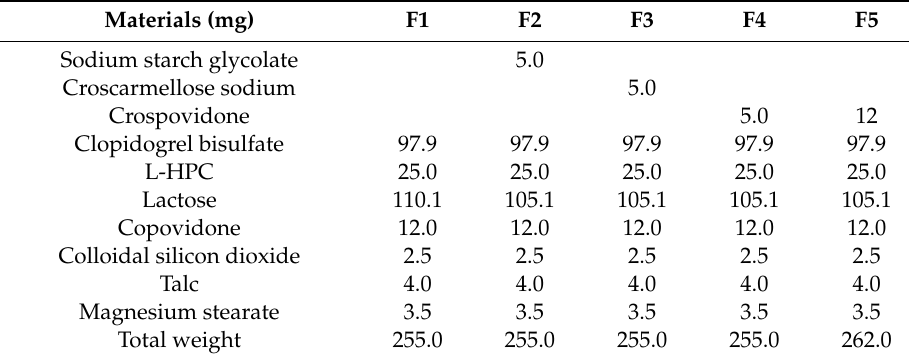
Table 1. Composition of the clopidogrel bisulfate core